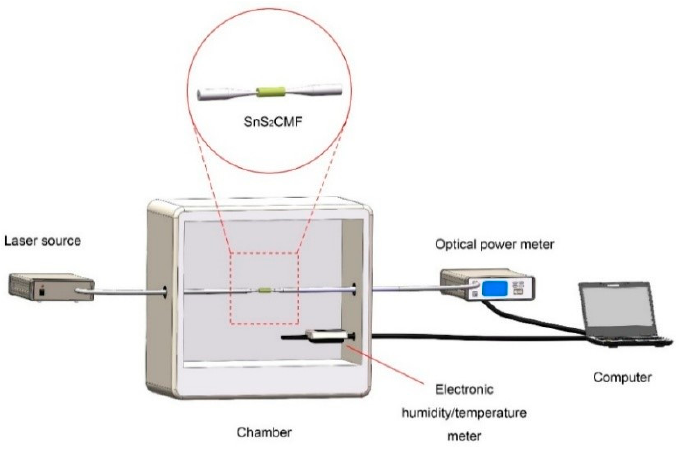
Figure 5. Experimental setup of the SnS 2 -coated MF device for humidity sensing.